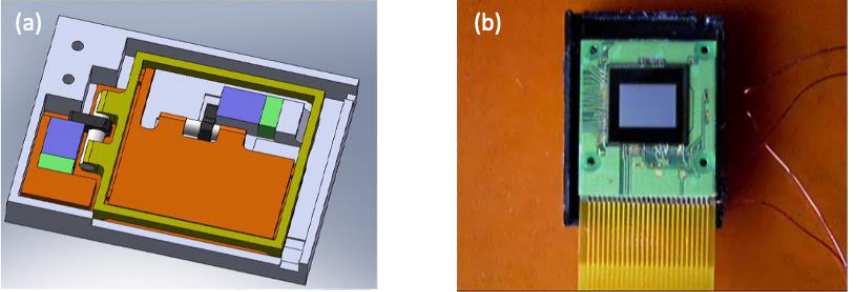
Figure 6. Two-axis stabilizer module with a Lobster USM. ( a ) The two-axis stage design. ( b ) The prototype image stabilizer with dimensions of 17 mm × 12 mm × 4 mm. prototype image stabilizer with dimensions of 17 mm × 12 mm × 4